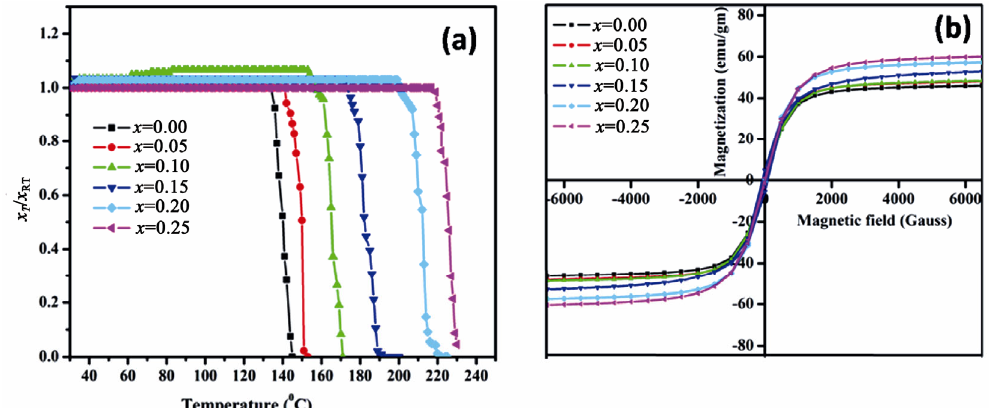
Fig. 7 Magnetic properties of the ferrites: (a) normalized AC susceptibility ( magnetic hysteresis